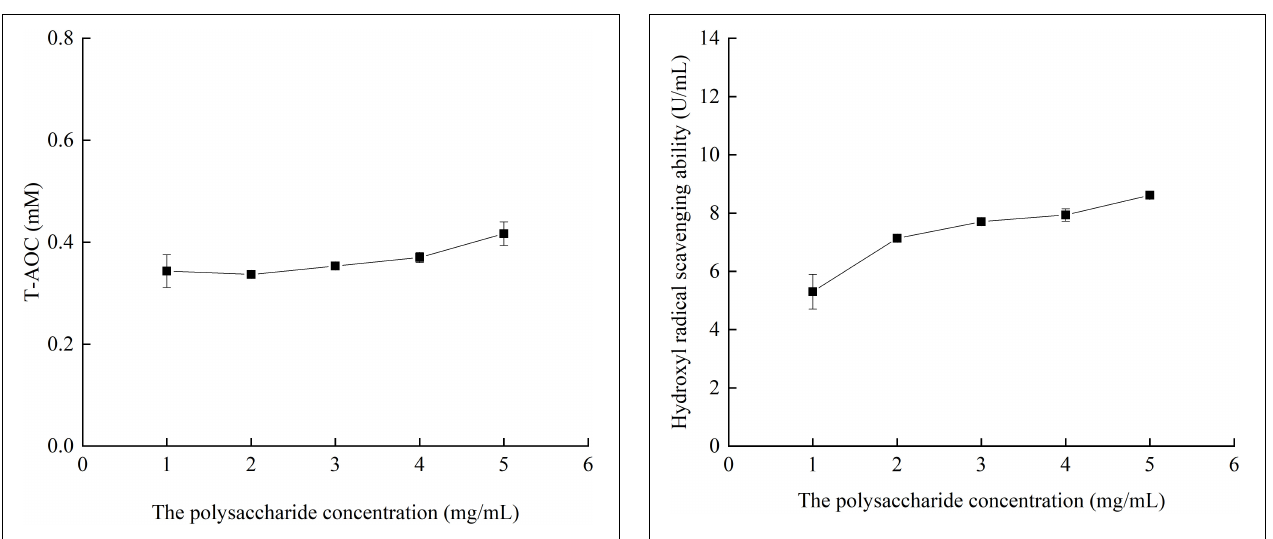
FIGURE 9 | Hydroxyl radical scavenging ability of crude polysaccharides from fruiting bodies with different concentrations in vitro.